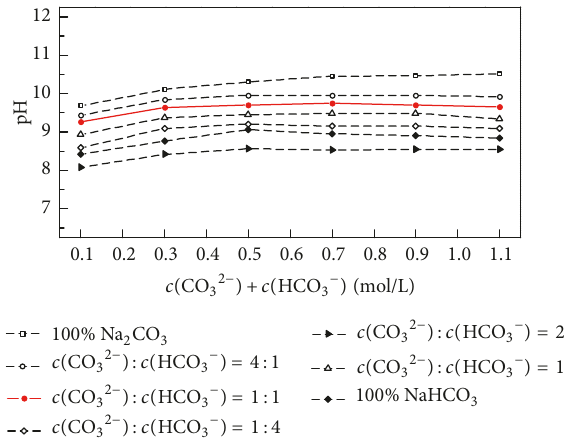
Figure 3: The ultimate pH at various leaching agent concentrations and mixture